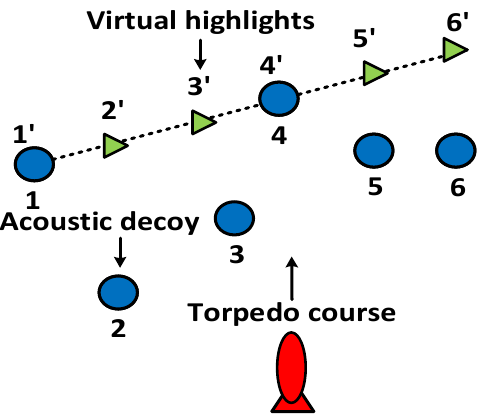
Figure 2. The suspended acoustic decoy simulating multi-highlight scale targets.